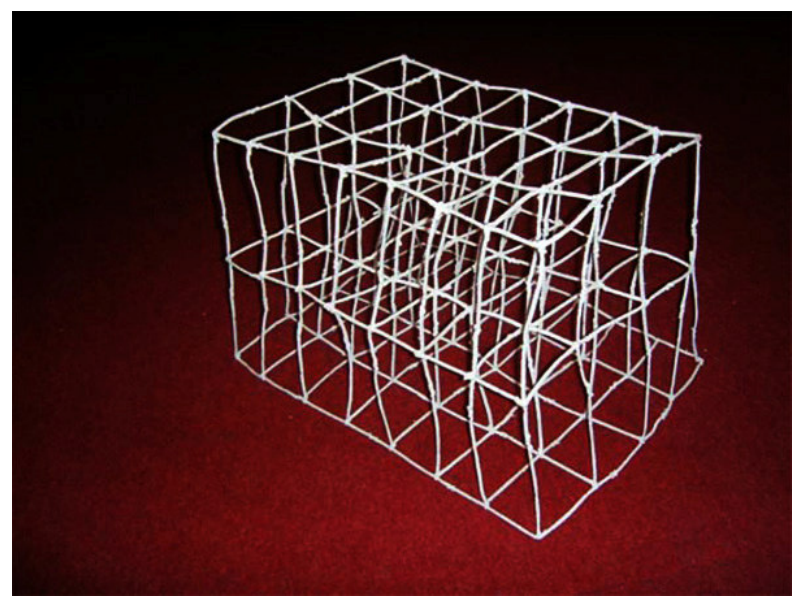
FIGURE 9. The reduced complex overtone multidimensionality as a three-dimensional roomy representation of the harmonic sound universe of a human